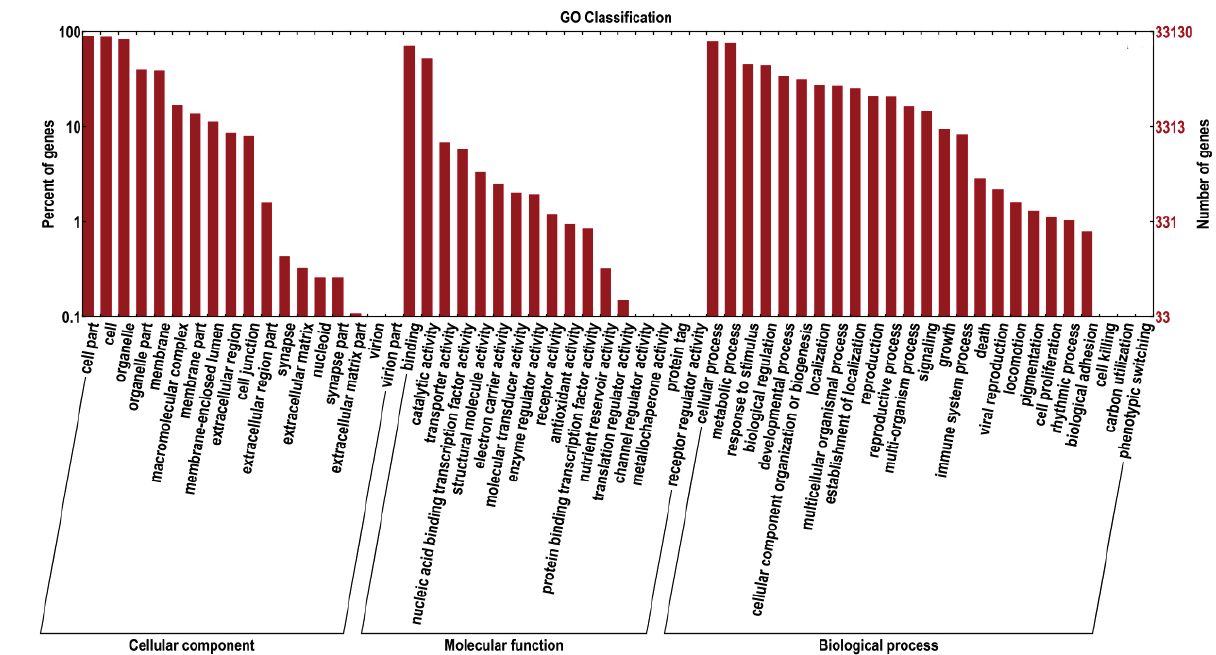
Figure 2. Functional annotation of genes based on gene ontology (GO) terms. GO analysis was performed at level 2 for the three main categories (biological process, cellular component and molecular function). Level 2 annotation was chosen because it greatly facilitates comparisons among sequence sets by pointing out the most significant differences. The right y -axis indicates the number of genes in a category. The left y -axis indicates the percentage of a specific category of genes in that main